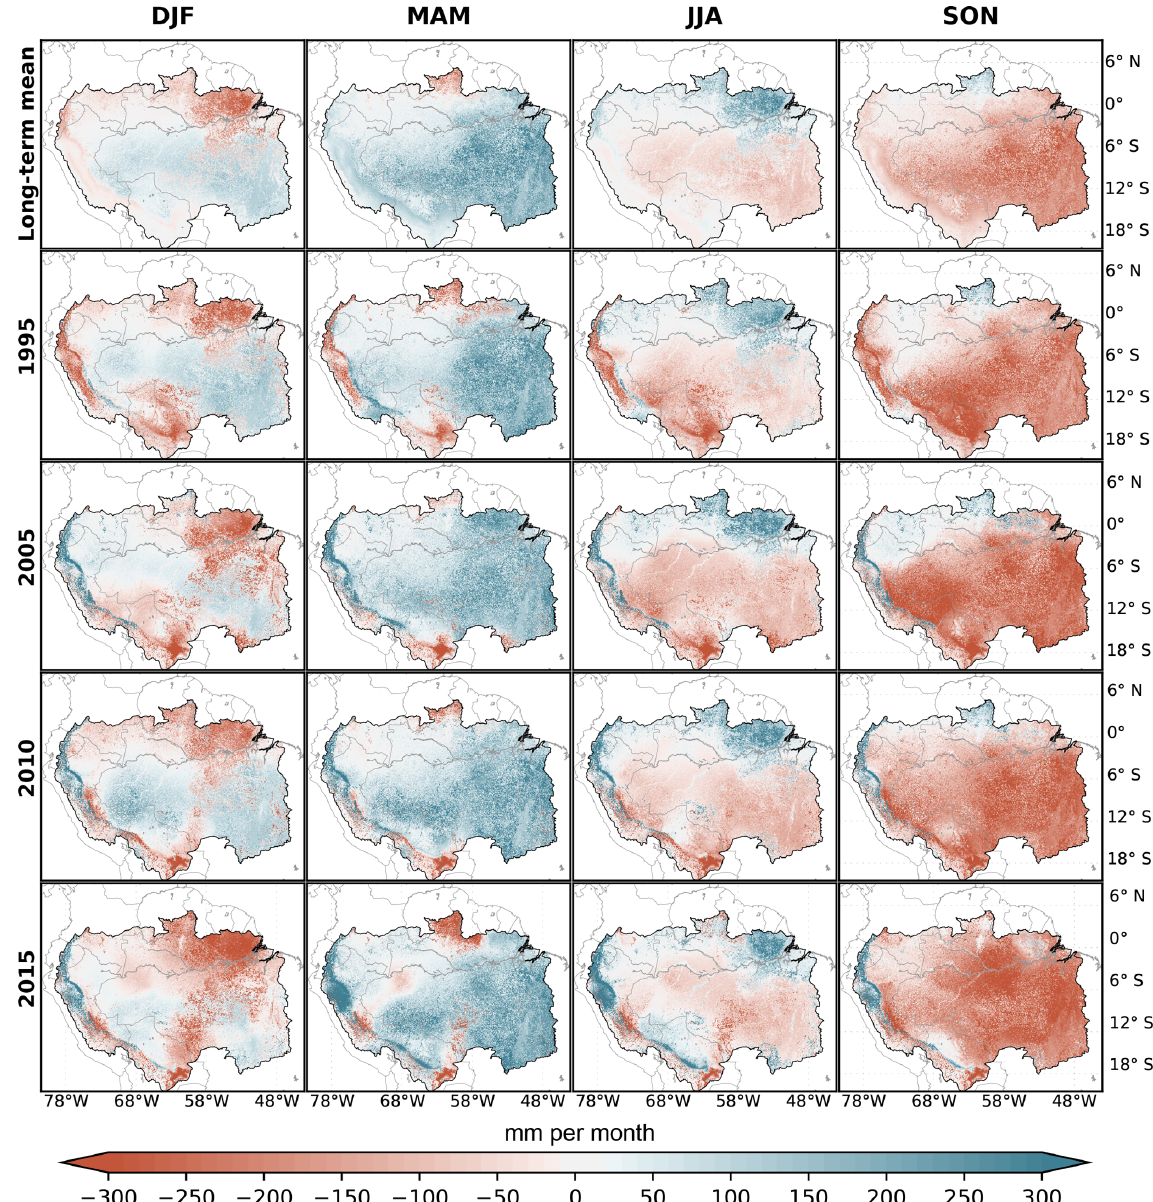
Figure 8. Seasonal dynamics of simulated sub-surface water storage from LHF in the Amazon River basin for extreme droughts during the simulation period. Long term mean is the mean seasonal anomaly for the 1980–2015 period, where DJF is December to February, MAM is March to May, JJA is June to August, and SON is September to